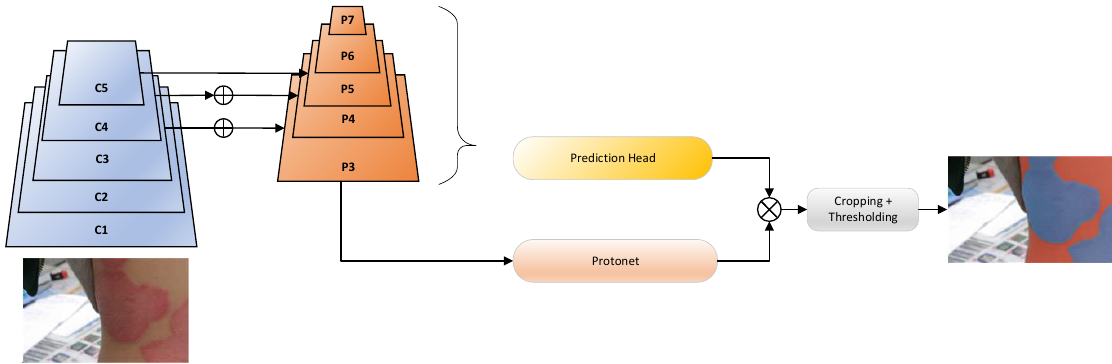
Figure 3. The systematic flowchart of the proposed instance psoriasis segmentation scheme based on You Only Look At CoefficienTs (YOLACT).